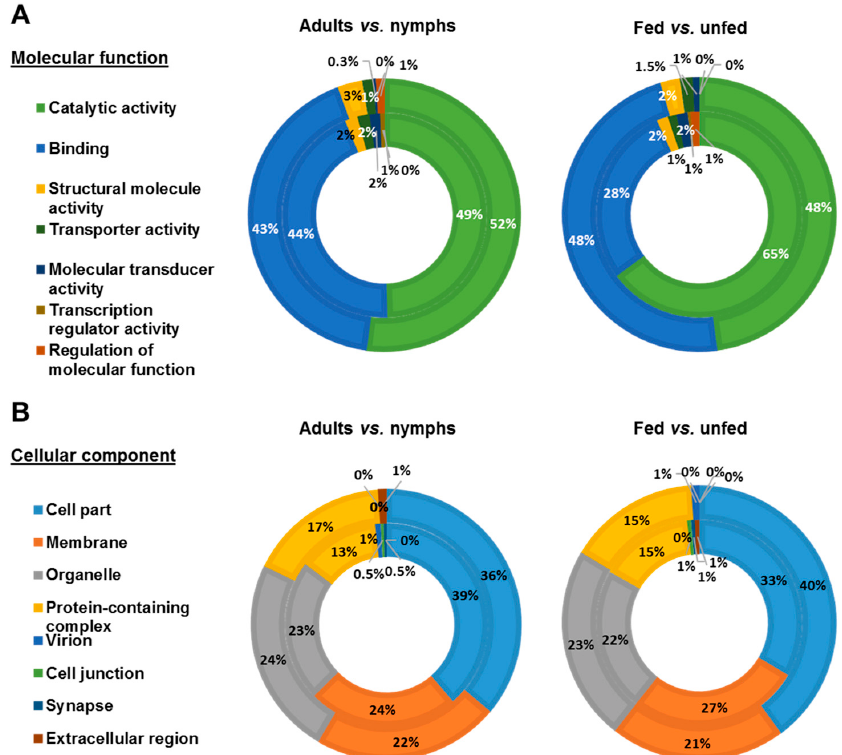
Figure 4. Molecular function and cellular component categorization of PRM proteins identified after proteomics analysis. Proteins were functionally annotated and grouped according to molecular function and cellular component using Blast2GO software and manual search. The same protein could have several GO annotations, a fact that was included in the results shown in the graphs. ( A ) Molecular function categorization. Left picture: Distribution of proteins identified in female adult PRM (inner circle) and nymph PRM (outer circle). Right picture: Distribution of proteins identified in fed PRM (inner circle) and unfed PRM (outer circle). ( B ) Cellular component categorization. Left picture: Distribution of proteins identified in female adult PRM (inner circle) and nymph PRM (outer circle). Right picture: Distribution of proteins identified in fed PRM (inner circle) and unfed PRM (outer